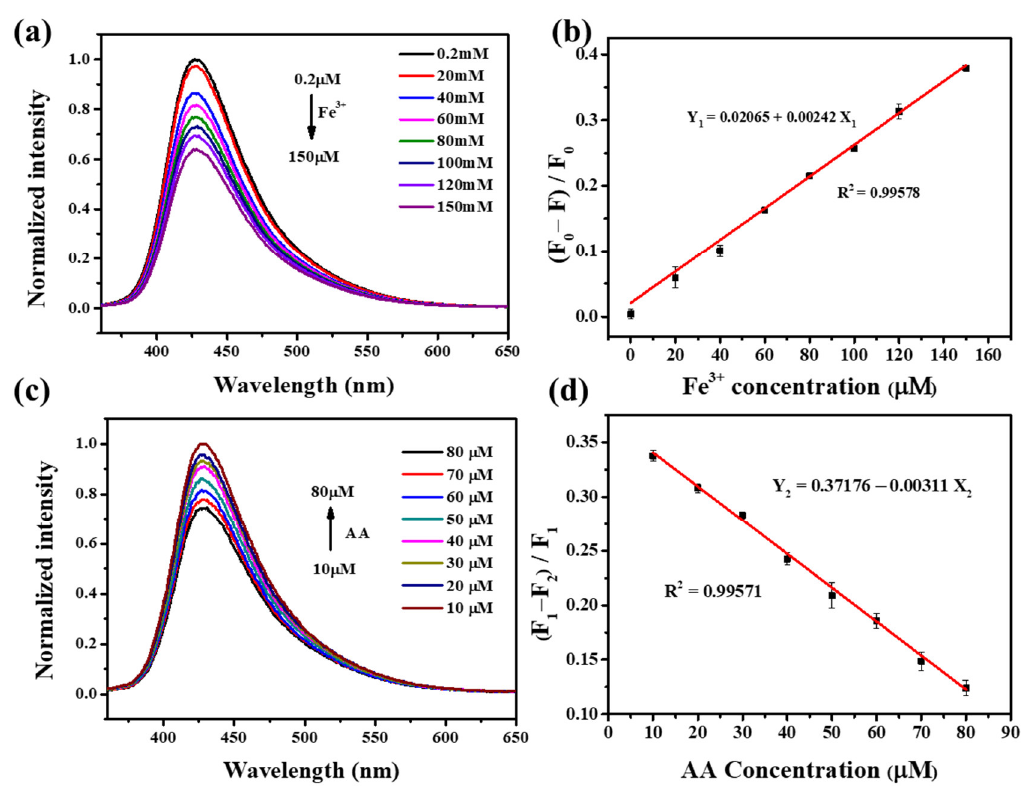
Figure 6. ( a ) The normalized fluorescence spectra of NFCDs with different Fe 3+ concentrations. ( b ) Linear relationship between the corrected fluorescence intensity and Fe 3+ concentration (F 0 is the fluorescence intensity without Fe 3+ and F is the corrected fluorescence intensity at different Fe 3+ concentrations). ( c ) Fluorescence spectra after adding AA to the solution of Fe 3+ (150 μM) and NFCDs for 20 min. ( d ) Linear relationship between the corrected fluorescence intensity and AA concentration (F 1 is the corrected fluorescence intensity of NFCDs/Fe 3+ without AA and F 2 is the corrected fluorescence intensity at different AA concentrations).